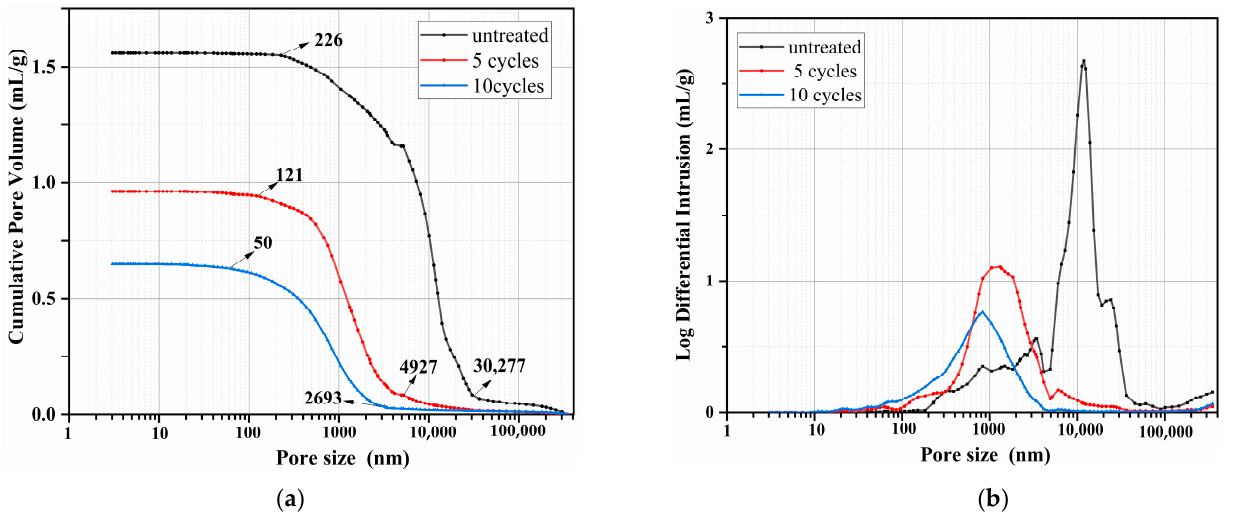
Figure 5. Pore size distribution of untreated and treated wood samples: ( a ) cumulative pore